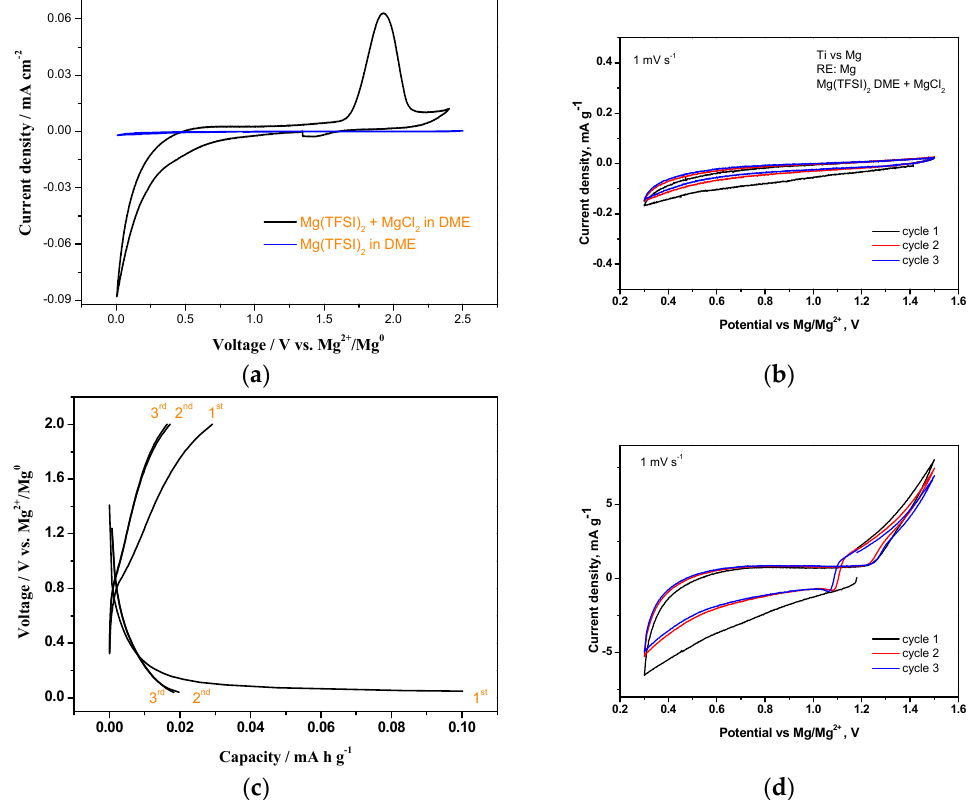
Figure 2. Control experiments without active material, using 0.5 M Mg(TFSI) 2 + 0.13 M MgCl 2 ·6H 2 O, in DME electrolyte versus Mg as reference and counter electrode: ( a , b ) Cyclic voltammetry (CV) at 1 mVs − 1 using different voltage windows (a: 0–2.5 V, b: 0.3–1.5 V). ( c ) Control experiments without active material under galvanostatic cycling at 0.1 C. ( d ) Cyclic voltammetry of LTO with 0.5 M Mg(TFSI) 2 + 0.13 M MgCl 2 ·6H 2 O in DME vs. Mg as reference and counter electrode. Note: The potential is plotted versus the Mg 2+ /Mg voltage of the reference electrode.